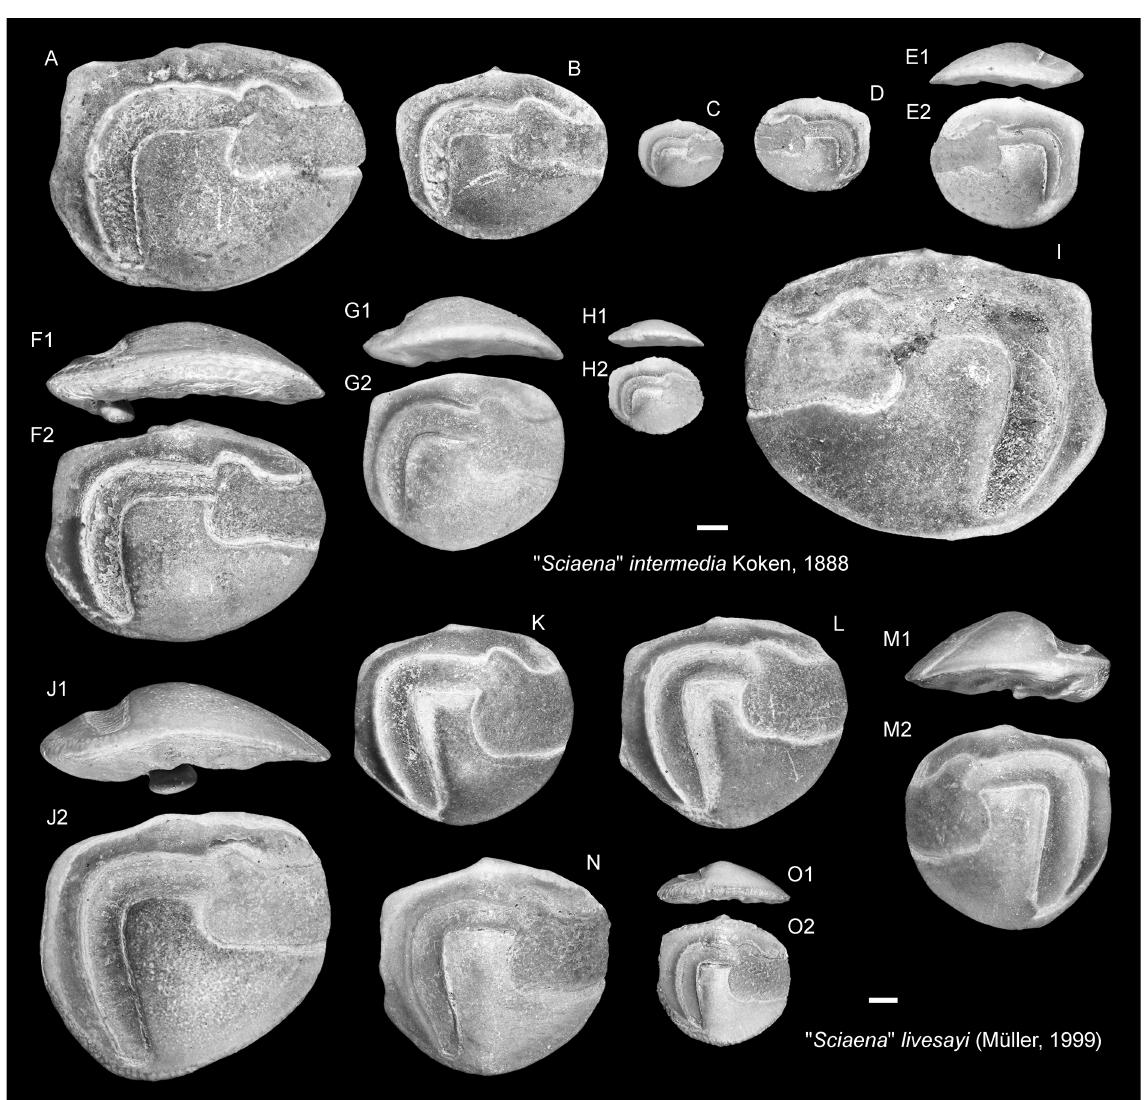
Fig. 35. Fish otoliths from the US middle and upper Eocene. A–I . “ Sciaena ” intermedia Koken,